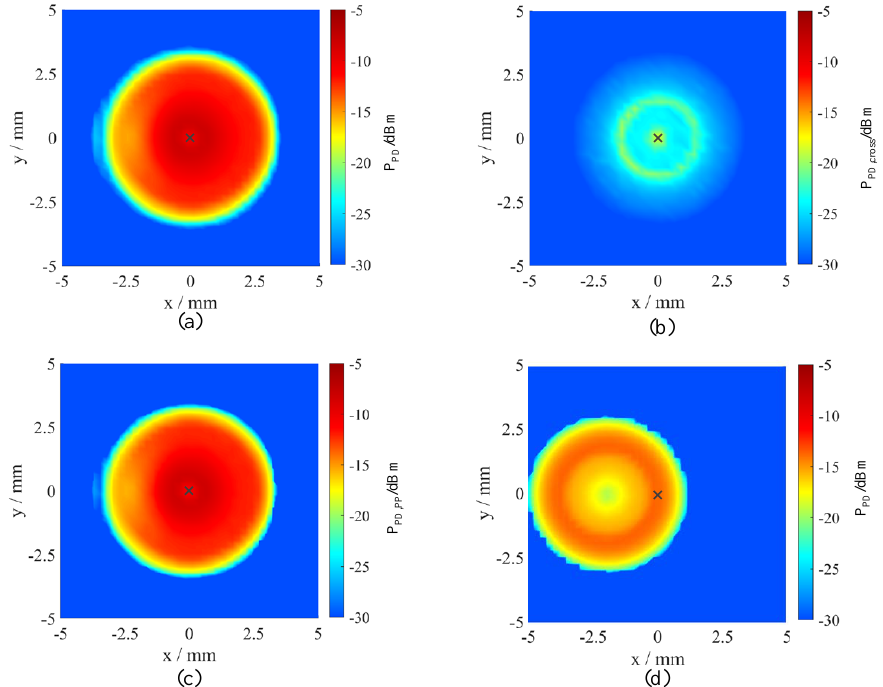
Figure 8. Incident power P PD and P PD cross over misalignment at z = 12.5mm. The ”x” marks the axis of rotation. ( a ) P PD /dBm for the hybrid lens. ( b ) P PD cross /dBm for the hybrid lens. ( c ) P PD PP /dBm for the hybrid lens. ( d ) P PD /dBm for the system with fully separated TX and RX (Section 2.3) in worst-case orientation, i.e., TX lens facing TX lens and RX lens facing RX lens. Note: The graphs are clipped